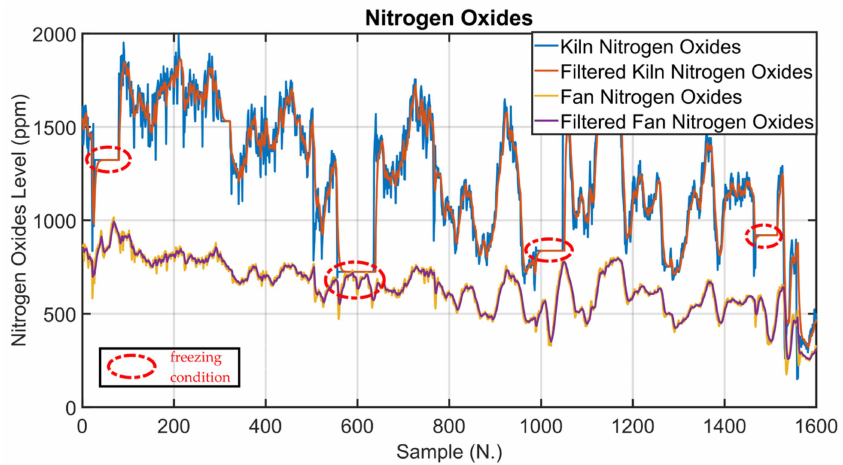
Figure 12. Rotary kiln APC system: data analysis results (nitrogen oxides).